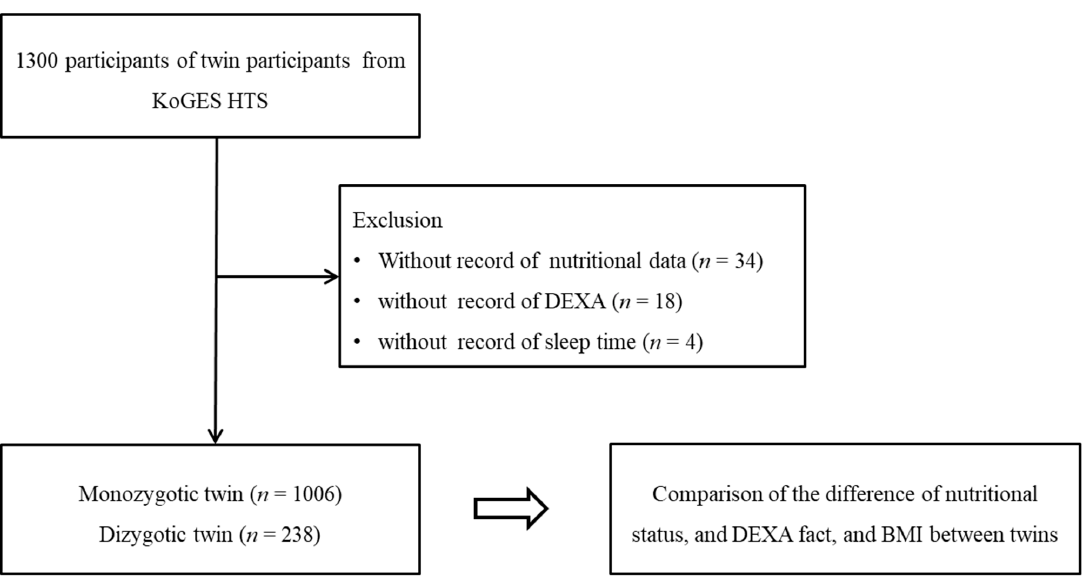
Figure 1. The 1006 of monozygotic twins and 238 of dizygotic twins were compared for the difference of nutritional status, DEXA fat, and body mass index (BMI) between twins.